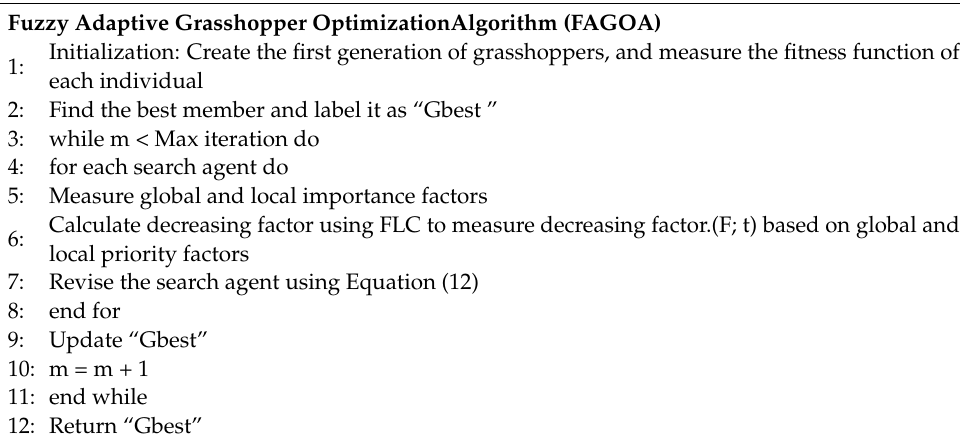
Algorithm 1. Pseudo code of